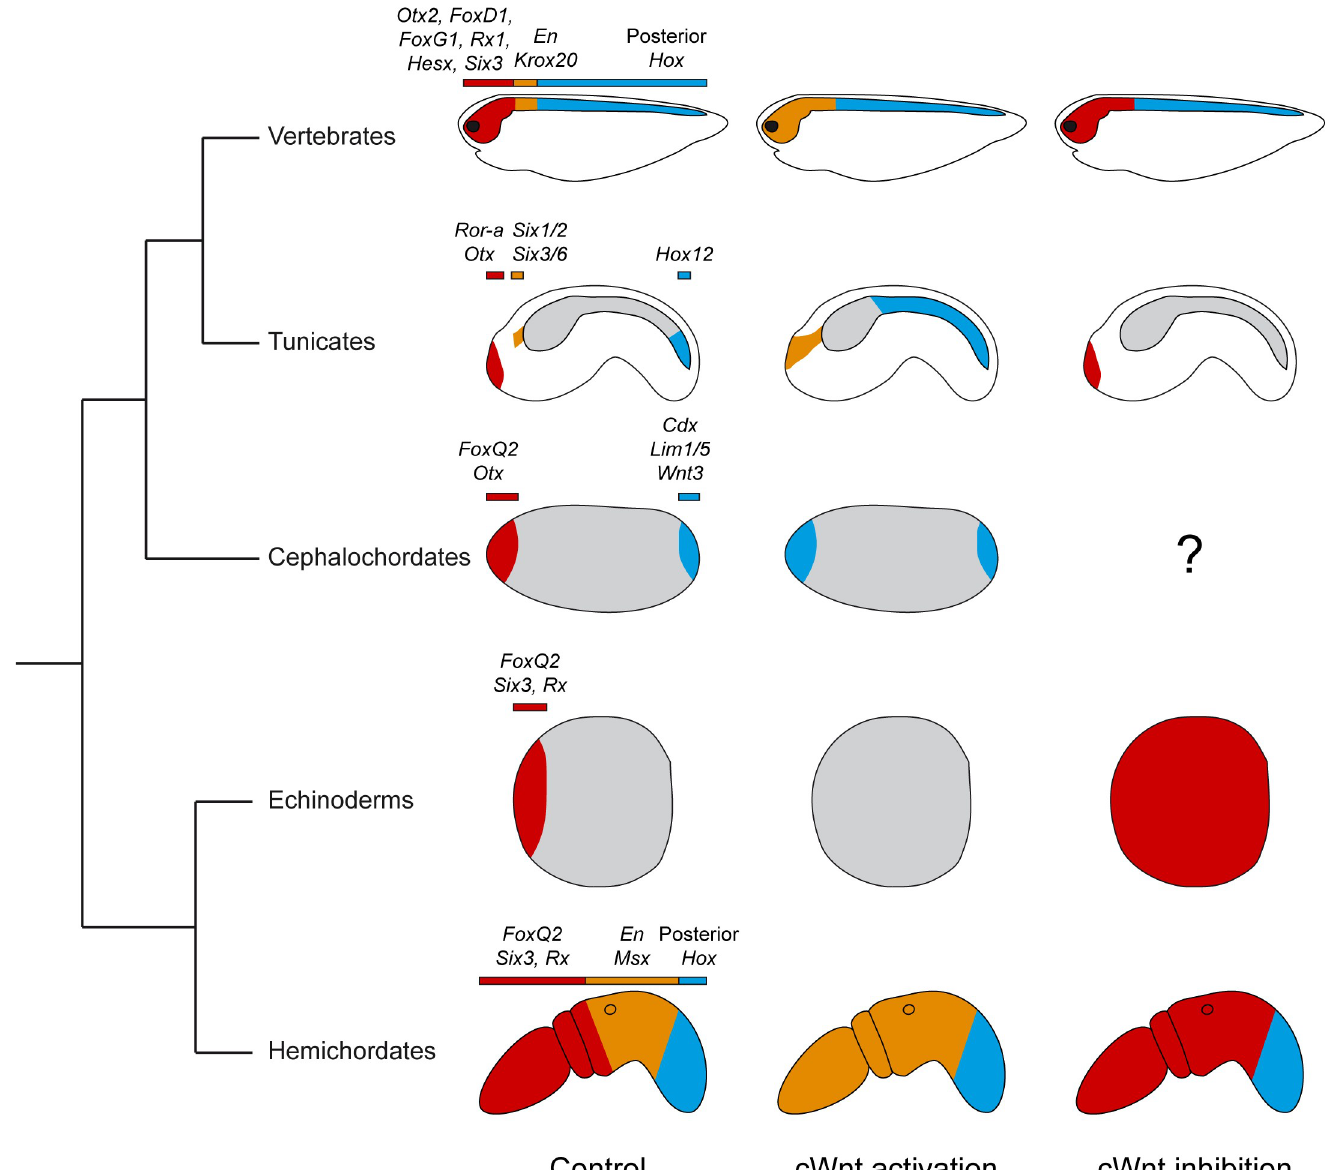
Fig 9. Summary of phenotypic effects of cWnt modulation on ectoderm AP patterning in deuterostomes. Schematic summary of data resulting from functional studies in vertebrates, amphioxus, echinoderms and hemichordate [10,18–22,55–59]. Note that the color code (red: anterior, orange: intermediate, blue: posterior) depicts regional domains along the AP axis and does not necessarily imply homology. Some of the key patterning genes whose expression has been determined in functional studies are listed above each domain.